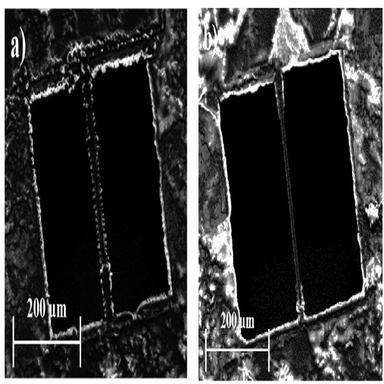
Pyrolytic carbon string coated with paracetamol microparticles before (a) and after (b) in situ regeneration by readout laser.